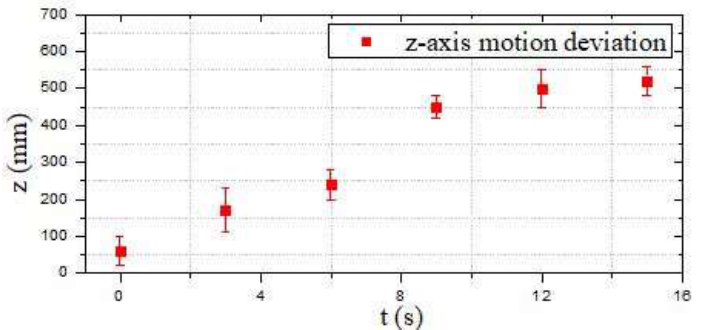
Figure 20. Motion deviation in the y-axis direction (the second experiment). Figure 19. Experiment for passthrough obstacles. Figure 21. Motion deviation in the z-axis direction (the second experiment). ( a ) ( b ) Figure 22. The second experiment of the SQP and GCOP algorithms. ( a ) SOP algorithm; ( b ) GCOP algorithm (the red ball represents an obstacle with a diameter = 500 mm and other balls represents an obstacle with a diameter = 200 mm). 6. Conclusions A novel amphibious spherical robot (ASR) with a more stable propulsion module and better performance than a previous version was developed. First, a new propulsion thruster is proposed to improve the dynamic performance and flexibility of the ASR, and the maximum thrust is increased from the previous 8.7 N to 17 N, which allows the robot to carry more sensors without compromising stability. Second, by designing an experi- mental platform with a pressure sensor, the linear relationship between the thrust and voltage of the water jet is measured in real time, thus laying a theoretical foundation for realising underwater movement and path-planning.